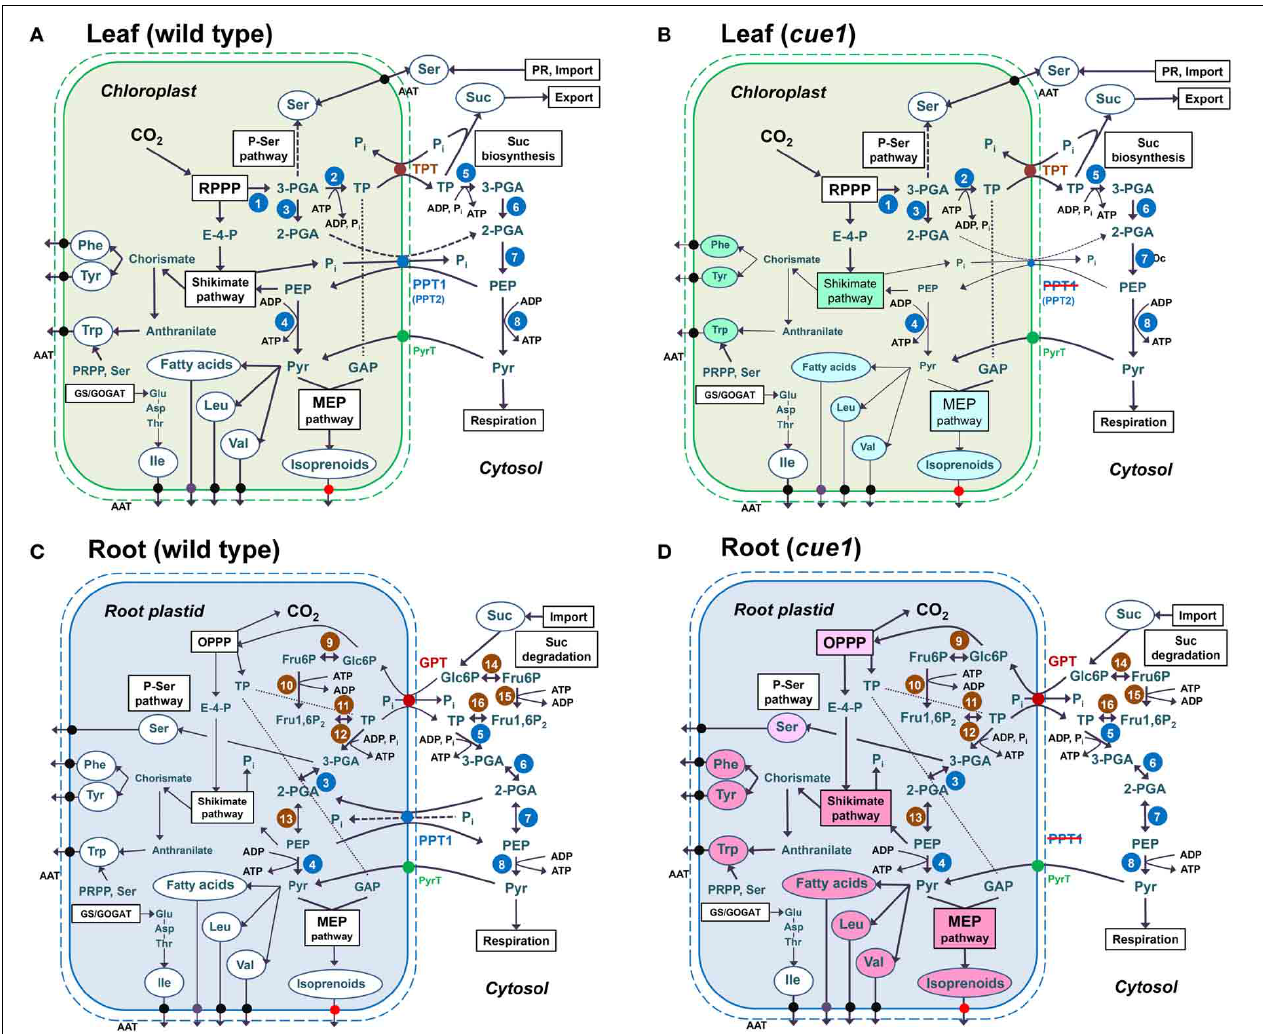
FIGURE 13 | Anabolic reaction sequences in chloroplasts (A,B) and root plastids (C,D) of wild-type (A,C) and cue1 mutant plants (B,D). In chloroplasts (A,B) CO 2 is assimilated in the reductive pentose phosphate pathway (RPPP; Calvin-Benson cycle) via ribulose 1,5-bisphosphate carboxylase/oxygenase (RubisCO;1). Its product, 3-PGA, is then converted to triose phosphates (TP) via the subsequent action of phosphoglycerate kinase and NADP glyceraldehydes 3-phosphate dehydrogenase (PGK/NADP-GAPDH; 2). TPs are exported via the TPT in counter exchange with inorganic phosphate (P i ) and subjected to Suc biosynthesis in the cytosol. Suc is the main transport sugar that is exported to the sinks via the phloem. In chloroplast glycolysis, 3-PGA can only be metabolized to 2-PGA via phosphoglycerate mutase (PGyM; 3), but not further to PEP. Under defined conditions, it can also enter the phospho-serine pathway of Ser biosynthesis. In leaves Ser is, however, mainly produced by photorespiration (PR) or is imported from non-green tissues, such as roots. TPs in the cytosol can undergo the glycolytic conversion to 3-PGA, involving PGK/NAD-GAPDH (5), and further to 2-PGA and PEP by the subsequent action of cytosolic PGyM (6) and enolase (ENO2; 7). PEP has to be imported to the stroma via PPT1 or PPT2 in counter exchange with either 2-PGA or P i . The latter derive, for instance, from the shikimate pathway, where PEP and erythrose 4-phosphate (E-4-P) serve as precursors. End products of the shikimate pathway are the aromatic amino acids (AAA) Phe and Tyr, which are synthesized from the intermediate chorismate, and Trp, which is synthesized from anthranilate as